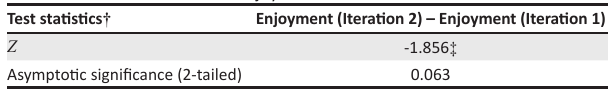
TABLE 3 : Test statistics for the enjoyment